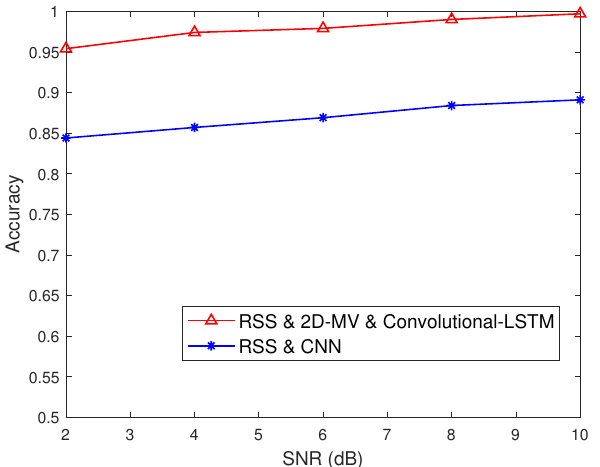
Figure 12. Comparison of results of the Convolutional-LSTM network and the CNN-based approach of [20] in a conference room